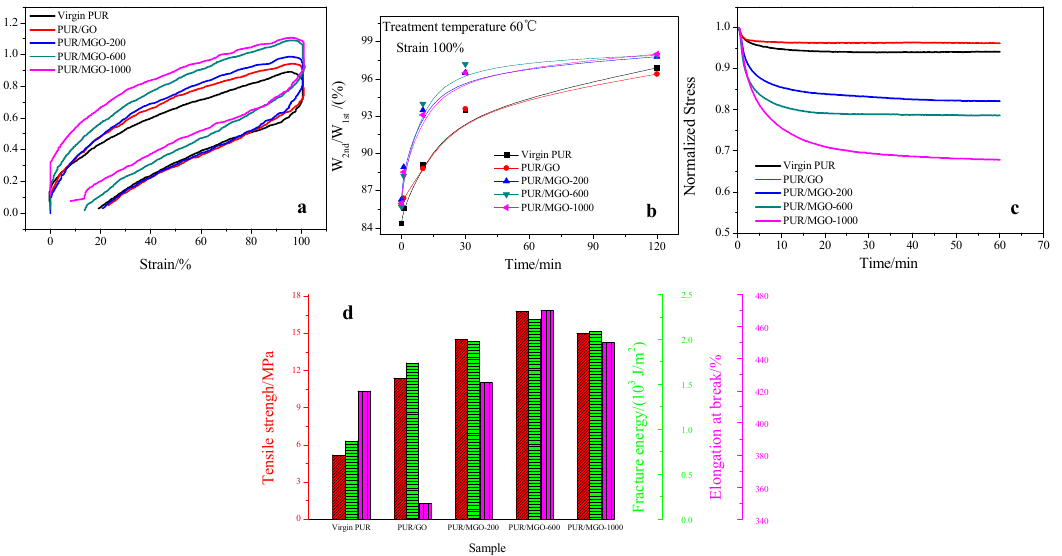
Figure 5. Tensile properties of PUR, PUR/GO and PUR/MGO. ( a ) cyclic loading-unloading; ( b ) hysteresis loss’s recovery; ( c ) stress relaxation; ( d ) mainly mechanical properties.